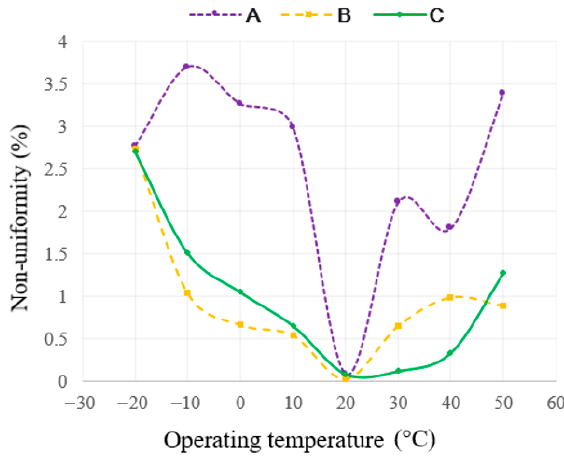
Figure 11. Non-uniformity of the conventional NUC.